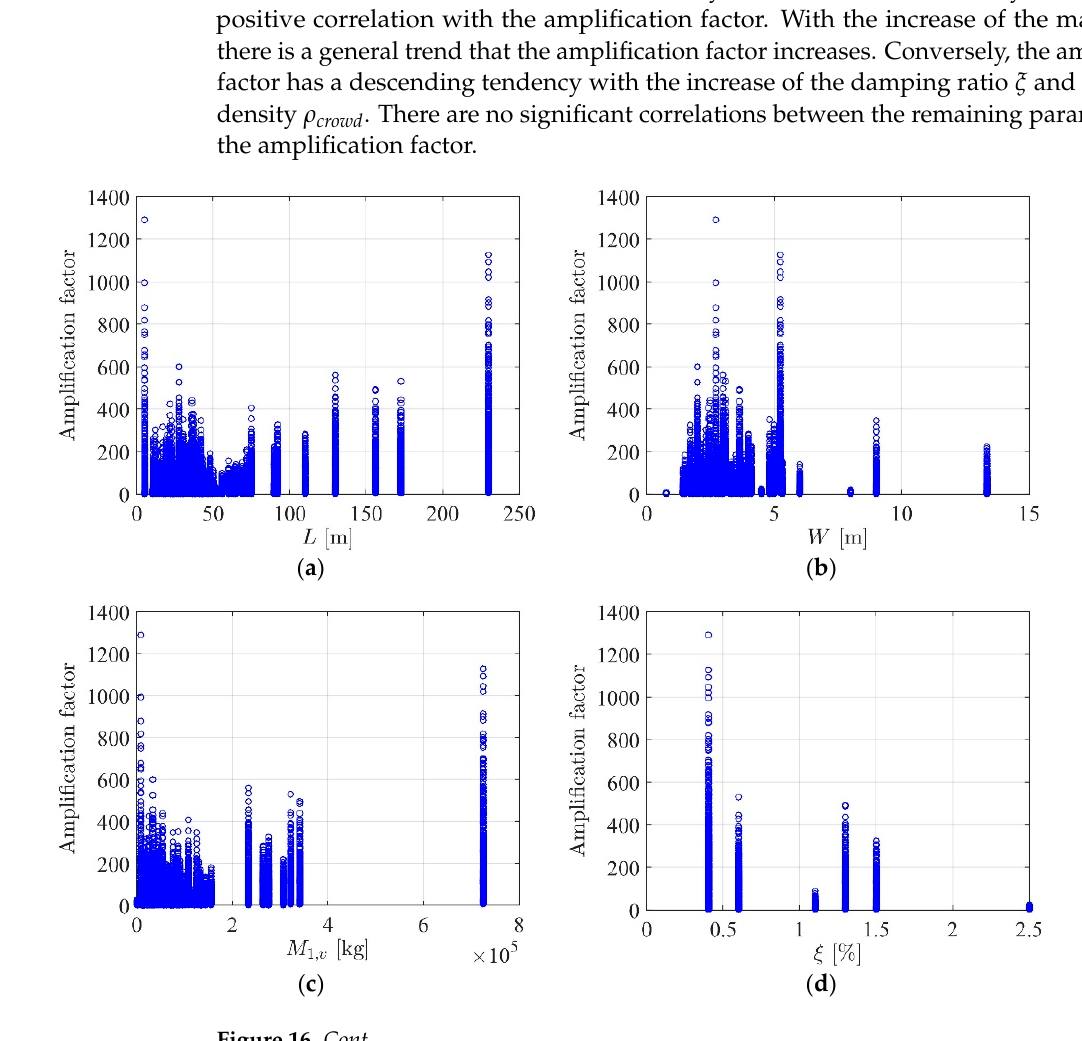
Table 6. Statistical values of input and output